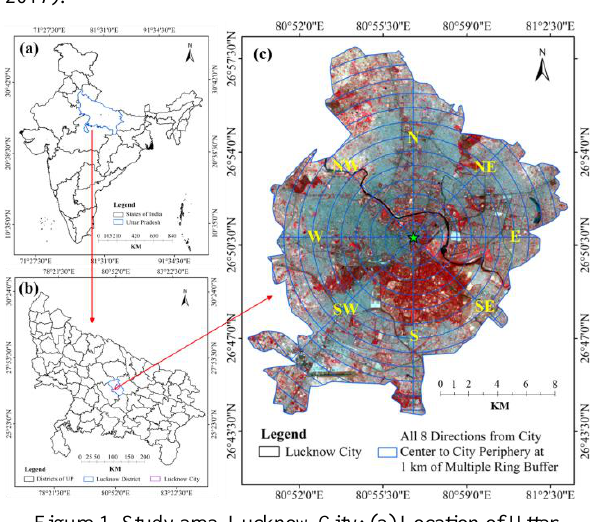
Figure 1. Study area, Lucknow City; (a) Location of Uttar Pradesh in India; (b) Location of Lucknow City in Uttar Pradesh; (c) Landsat 8 Standard False Colour Composite (FCC) of Lucknow City of 01/06/2019 with buffer zones and